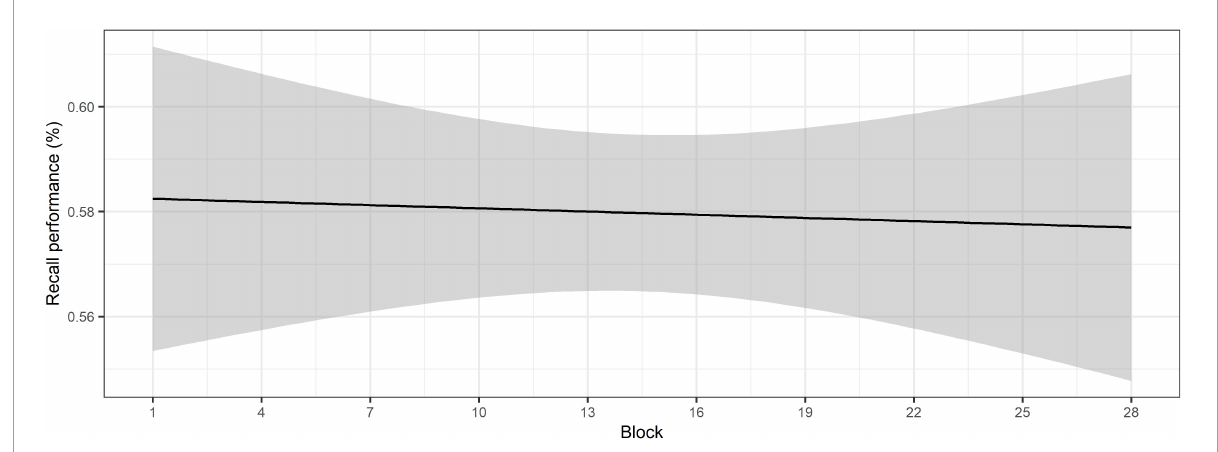
FIGURE4 Recall performance over the course of the SWIR test blocks. The shaded area shows the confidence intervals at the 95%-level.